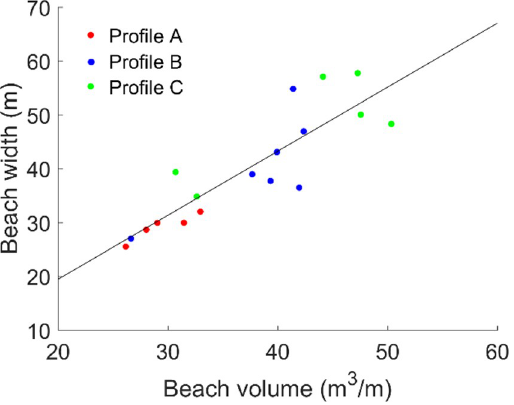
Fig 12. Observed relation between beach volume (V berm ) and beach width (y G -y S